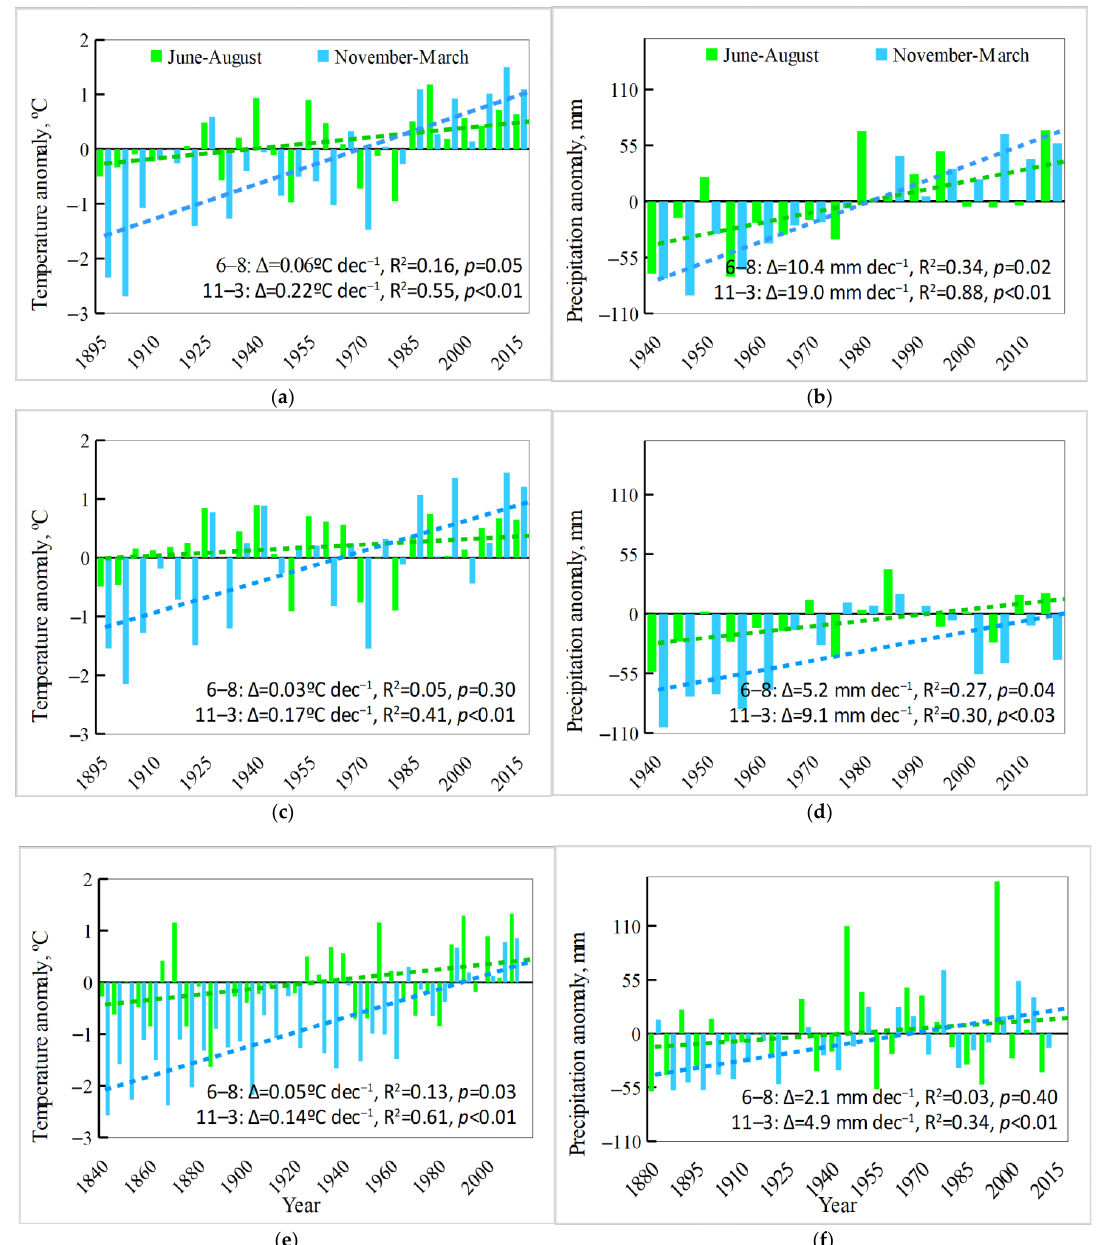
Figure 9. Anomalies of mean temperature and total precipitation for warm (June–August) and cold (November–March) seasons, grouped by 5-year periods, for the following stations: Cherdyn’ ( a , b ) and Troicko – Pecherskoe ( c , d ), Northern Urals, and Taganay – Gora ( e , f ), Southern Urals. Anomalies are relative to th e mean values of the 1961−1990 period. The dotted lines show linear trends. Statistics correspond to these linear regressions.